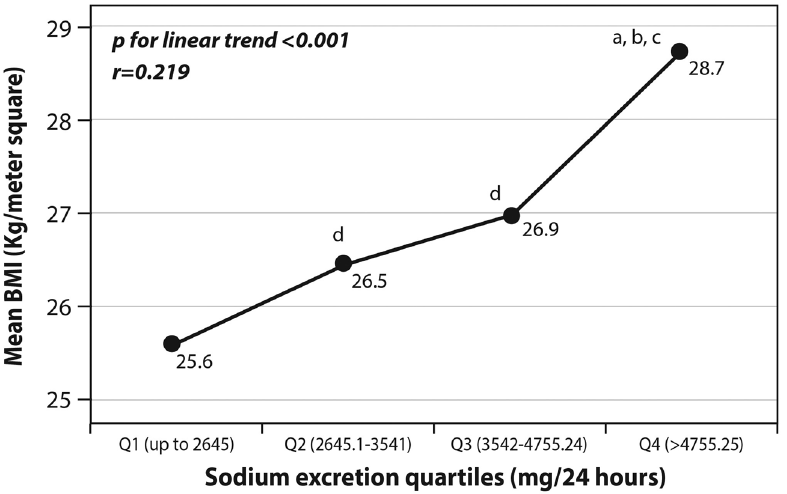
Figure 4. univariate associations between sodium excretion quartiles and mean BMI. Statistical differences between sodium excretion levels (analyzed using One-Way Analysis of variance [ANOVA]) are represented by the following letters: a = significantly different than Q1 (p < 0.05); b = significantly different than Q2 (p < 0.05); c = significantly different than Q3 (p < 0.05); d = significantly different than Q4 (p < 0.05).